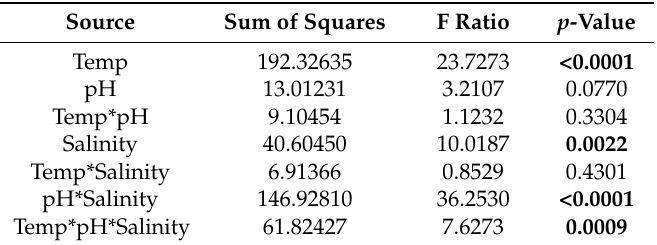
Table 3. Results of full factorial regression investigating the effect of changing temperature, pH, and rock salt concentration on mean dimensionless erosion rates (Er/u*) for a natural soil dominated by montmorillonite clay minerals (r 2 = 0.57, alpha = 0.05).